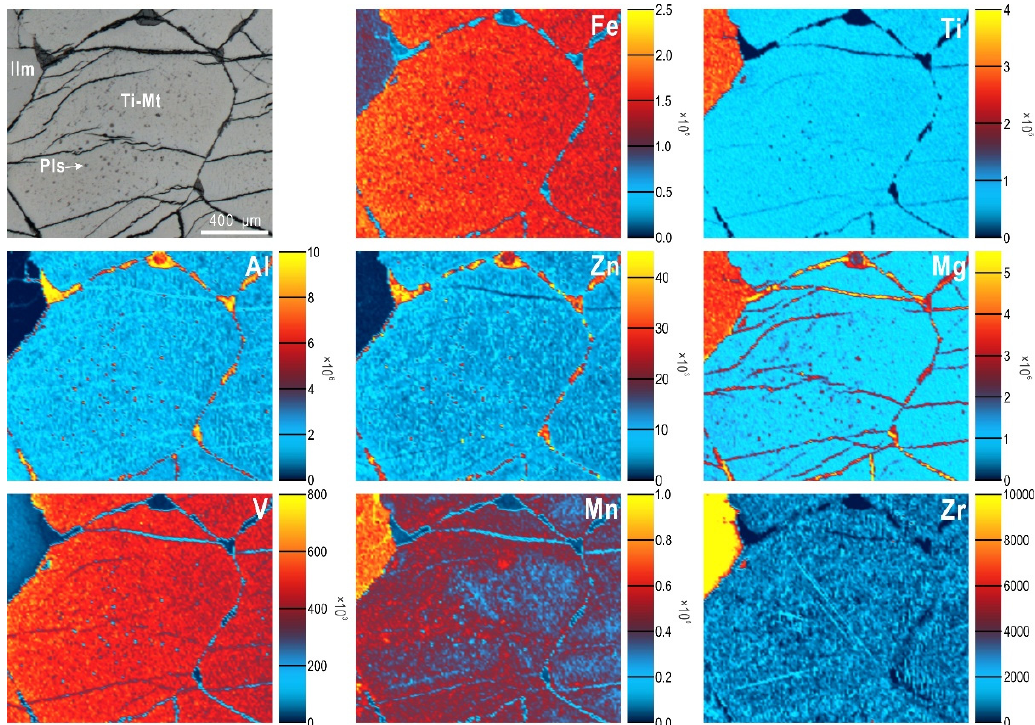
Figure 2. Reflected light photomicrograph (top left) and LA-ICP-MS maps showing patterns of trace element distribution in titanomagnetite (Ti-Mt) with inclusions of pleonaste (Pls) and crosscutting fractures. Note the concentration of Al, Zn, and Mg along the grain boundary, whereas the fractures show relative enrichment in Mg and corresponding depletion in V, Mn, and Zr. Manganese and Zr are both higher in adjacent ilmenite (Ilm) but show antipathetic correlation with one another along fine linear arrays within the grain, i.e., Mn-depleted and Zr-enriched. Scales are in counts-per-second. Extended maps are shown in Supplementary Materials Figure S2.